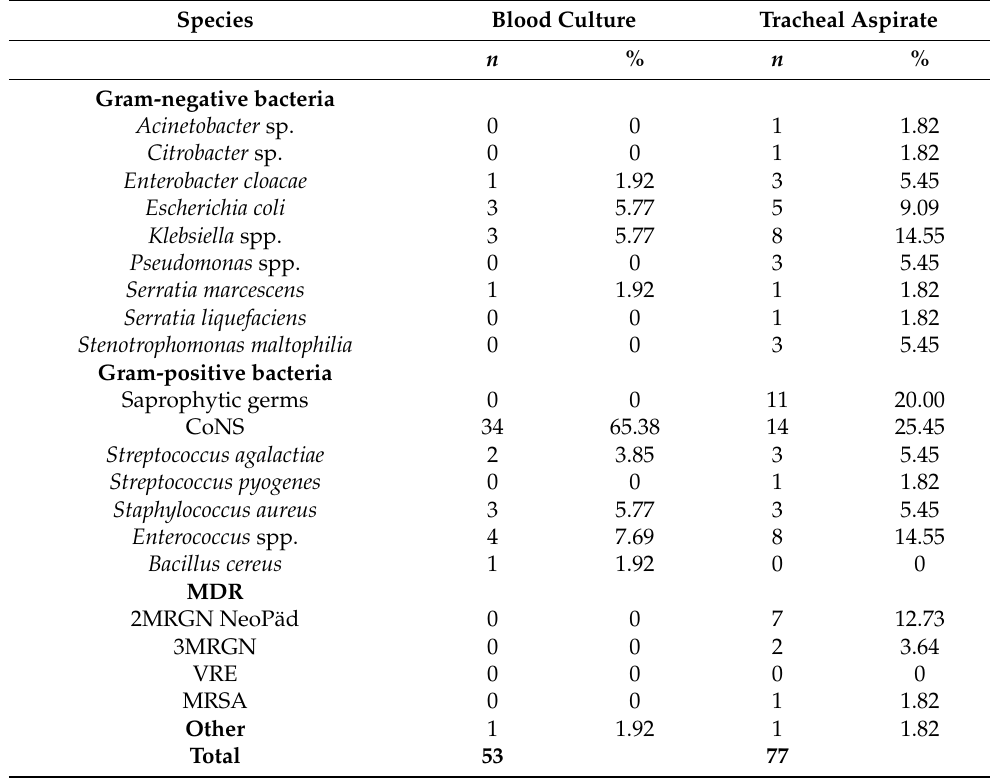
Table 1. Bacteriological results of blood cultures in patients with sepsis and tracheal aspirates in pneumonia patients. Species Blood Culture Tracheal Aspirate n % n % Gram-negative bacteria Acinetobacter sp. 0 0 Citrobacter